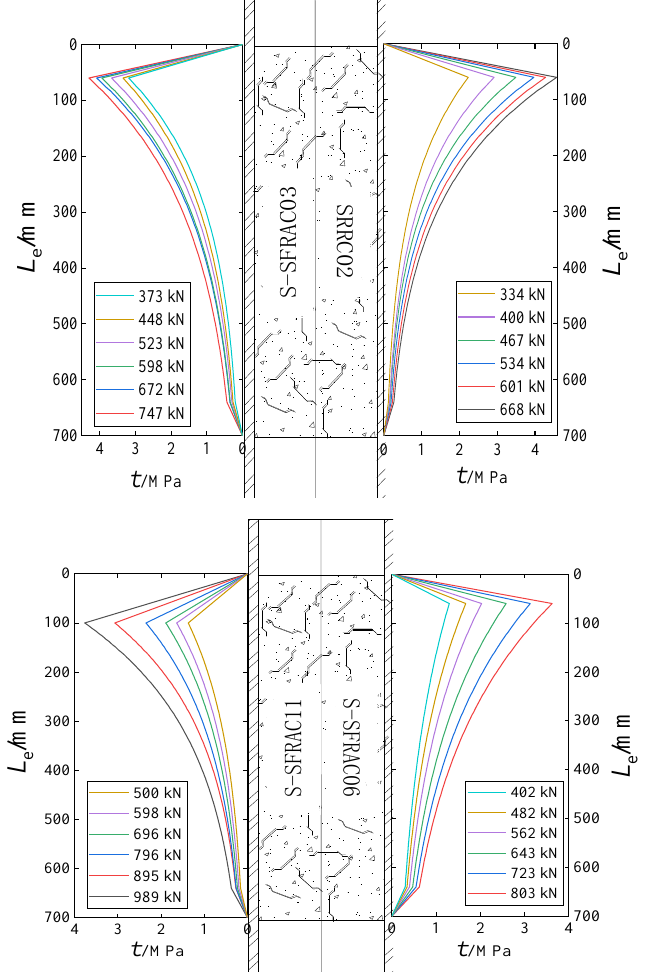
Figure 12. Bond stress distributions at the steel flanges in the load increase section.